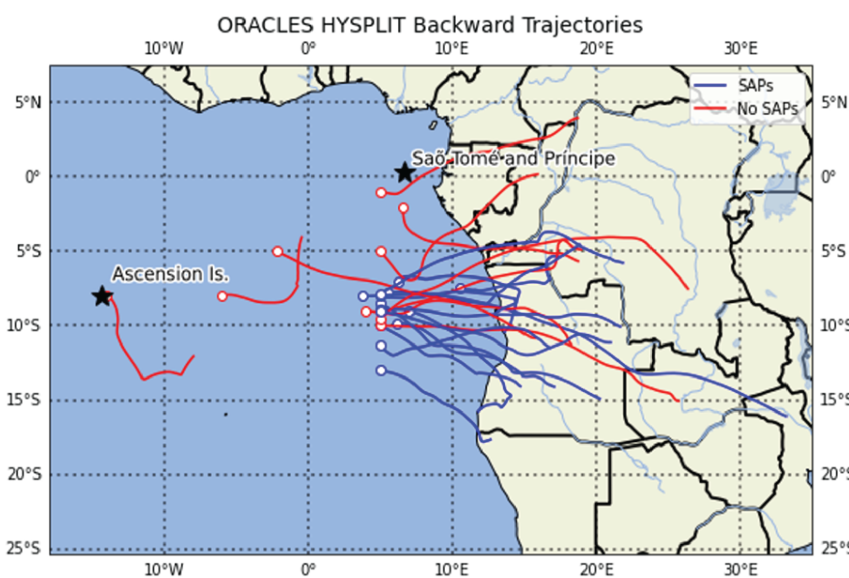
Figure 13. Location of 2017 and 2018 aerosol sampling legs and their 48h HYSPLIT backward trajectories. Backward trajectories of SAPs (blue) show a possible source air mass region in northern and central